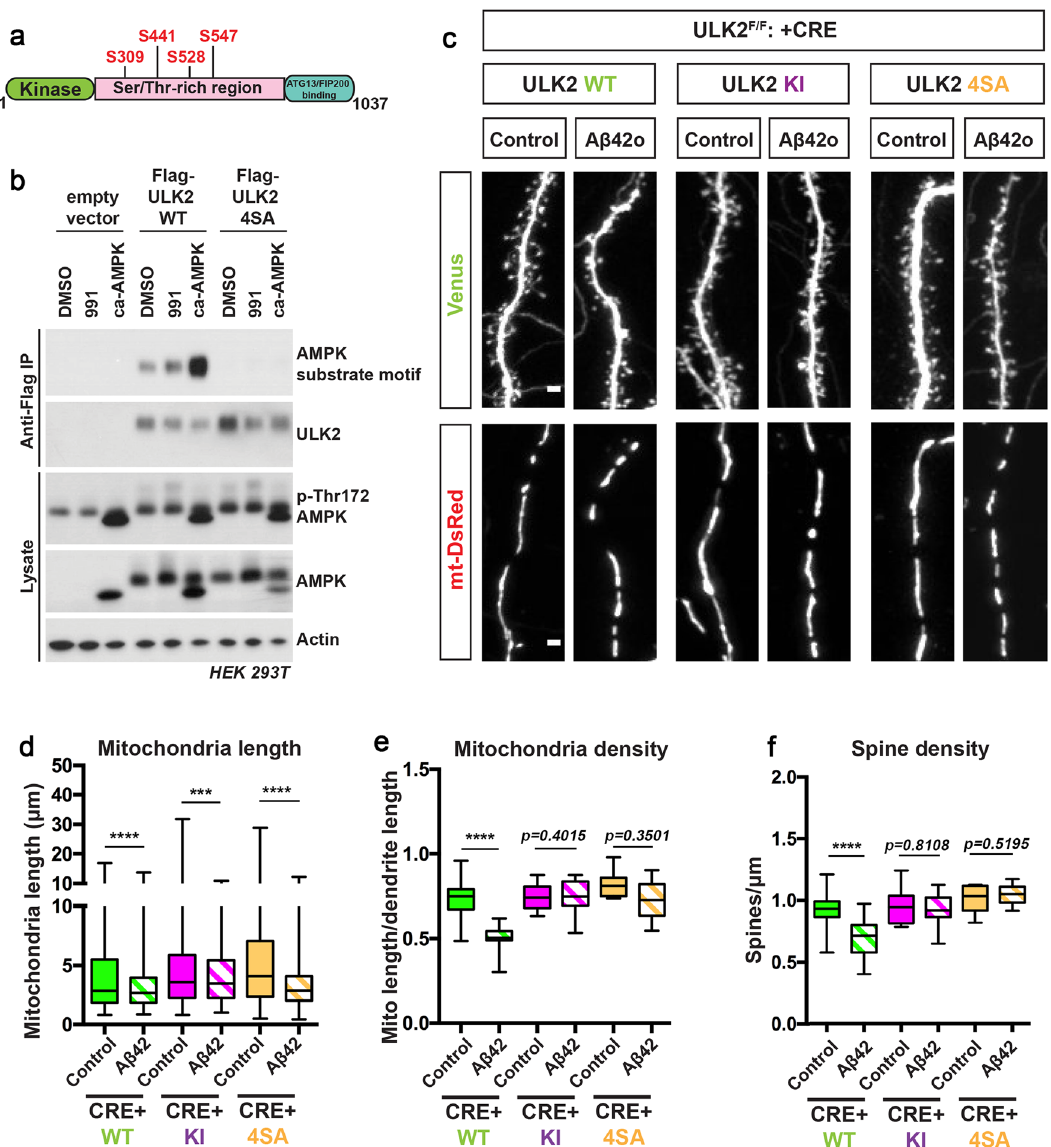
Fig. 9 | AMPK-mediated phosphorylation of ULK2 is crucial for oligomeric A β 42-induced synaptotoxicity and lossof mitochondrial biomass. a Schematic of ULK2 domain structure highlighting the four predicted AMPK-mediated phos- phorylation sites (seeSupplementary Fig. S8) conservedin ULK1 and ULK2. b Flag- mULK2WTorFlag-mULK24SA(thefourconservedphosphorylationsitesshownin Supplementary Fig. S8b are mutated to alanine) was overexpressed in HEK293T cells co-expressing either GST or GST-ca-AMPK α 1(1 – 312)